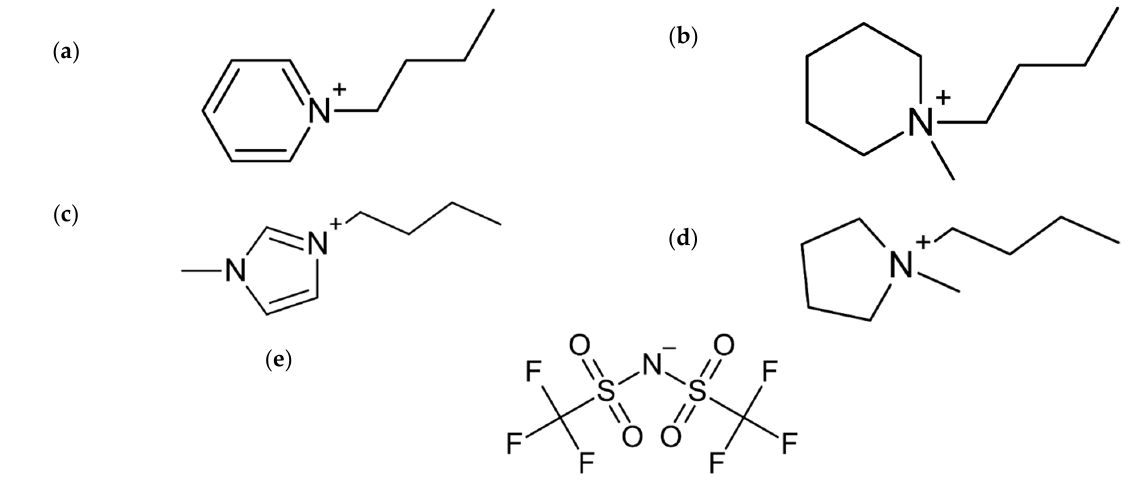
Figure 4. Molecular structure of the cations and anions used ( a ) [BPy]+, ( b ) [PP 14 ] + , ( c ) [BMIm]+, ( d ) and ( e ) [TF 2 N] − . Table 2. Theoretical global extraction constants (K global ) and selectivity validation using experimental data [22] for different ILs when TBP is